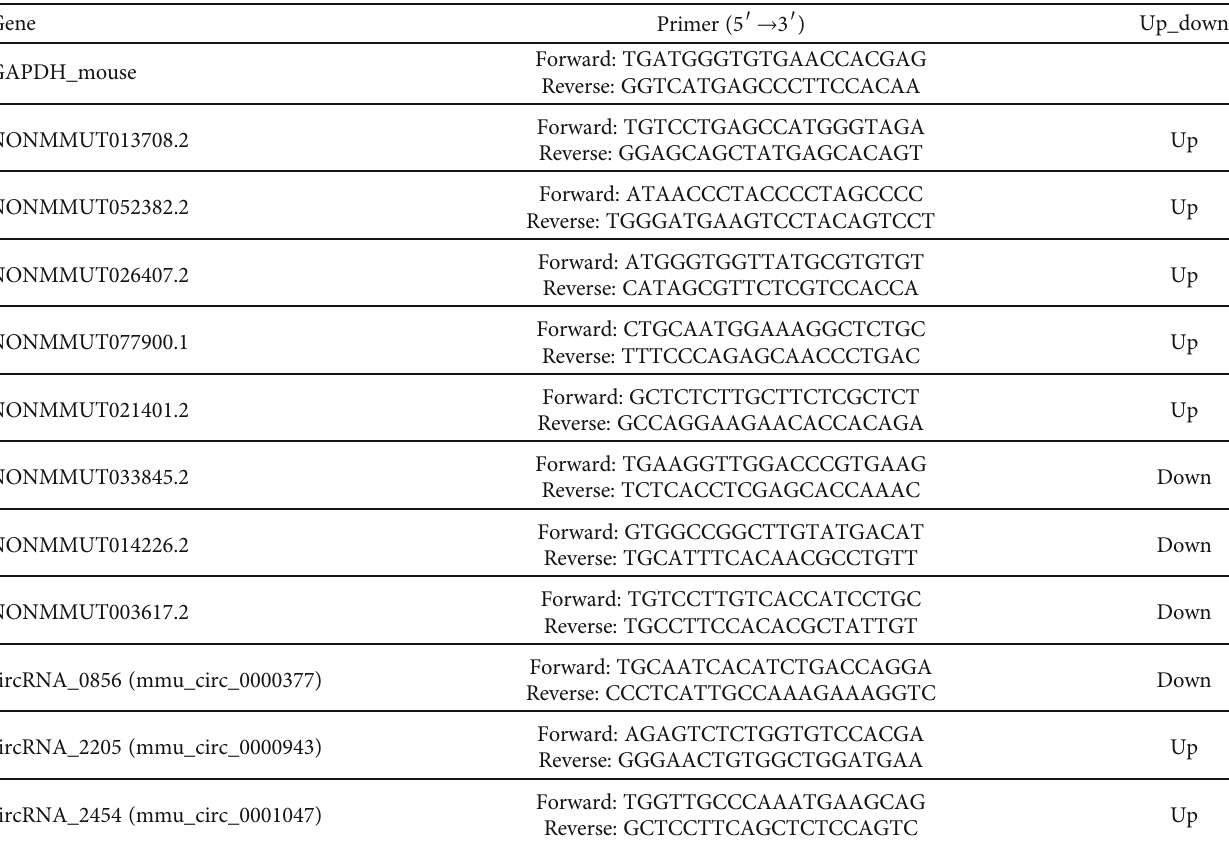
Table 2: Primers used in this